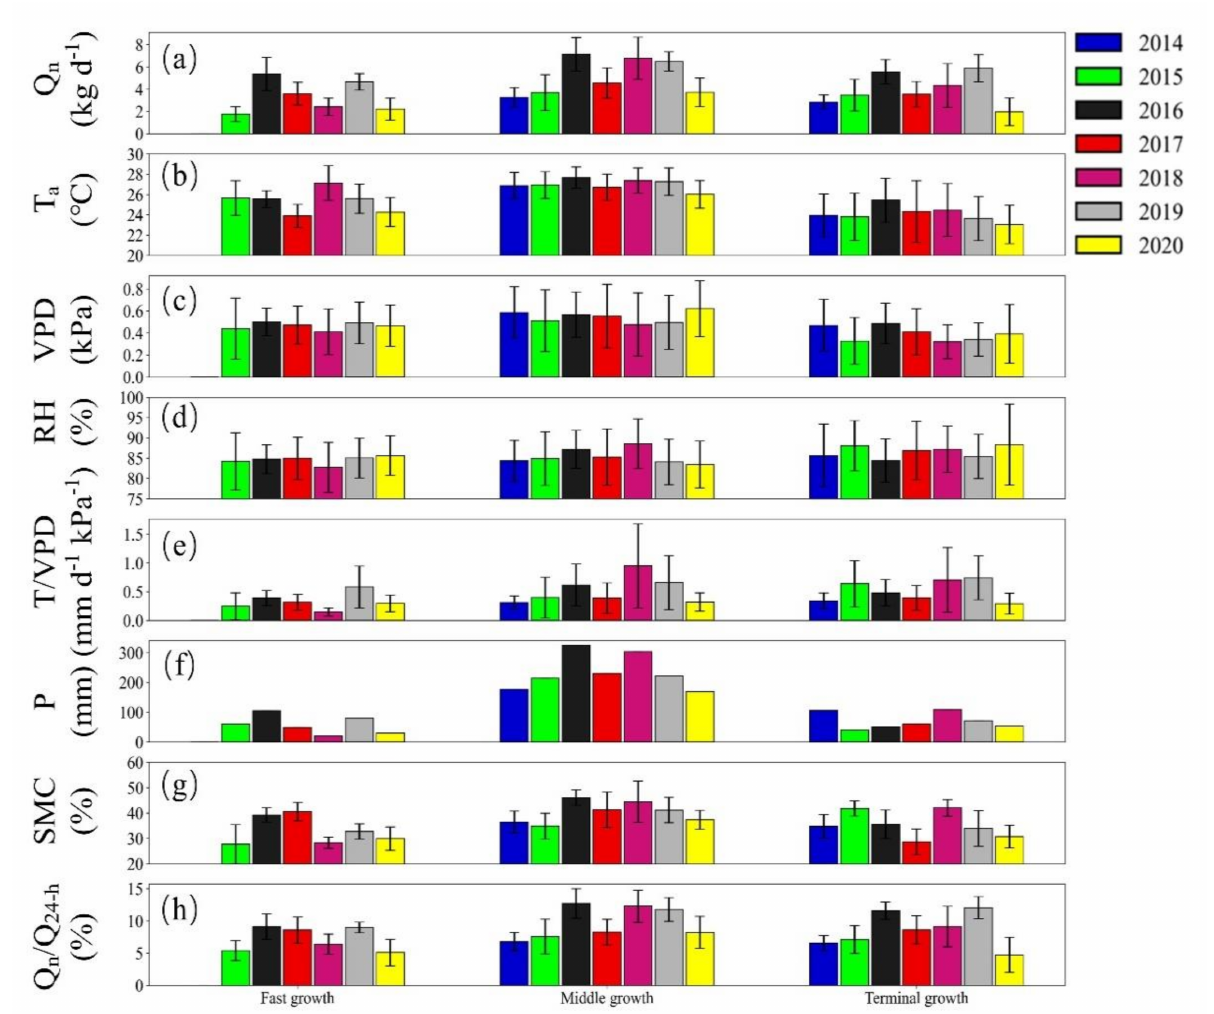
Figure 4. Seasonal courses of nighttime mean ( a ) sap flow rate (Q n ), ( b ) air temperature (T a ), ( c ) vapor pressure deficit (VPD), ( d ) relative humidity (RH), ( e ) canopy conductance (T/VPD), ( f ) total nighttime precipitation (P), ( g ) soil moisture content (SMC), and ( h ) proportion of nighttime sap flow to total 24-h sap flow (Q n /Q 24-h × 100) at each of three growing periods (i.e., fast growth, middle growth, and terminal growth) over 2014–2020. The data bars are the annual mean values for all parameters, except for the annual total for P at each growing stage. Note: (n = 6 for fast growth period, and n = 7 for middle and terminal growth